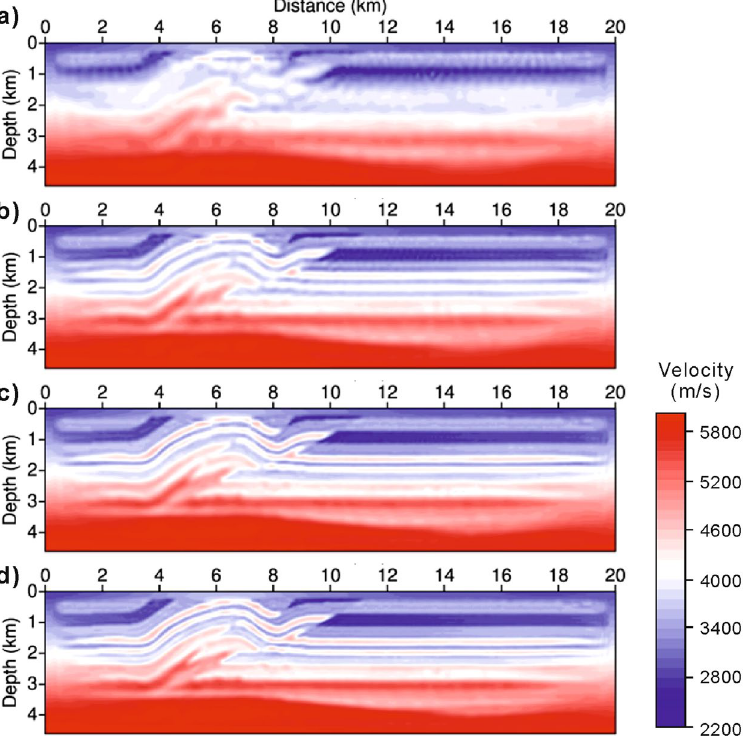
Figure 3. Shot-encoded FWI with the restarted L-BFGS algorithm. ( a , b , c , d ) Reconstructed velocity profiles corresponding to the respective inversion stages of four frequency-band data sets (2 − 4, 4 − 6, 6 − 8, 8 − 10 Hz). The crosstalk effect is eventually suppressed because of the cumulative randomness in the